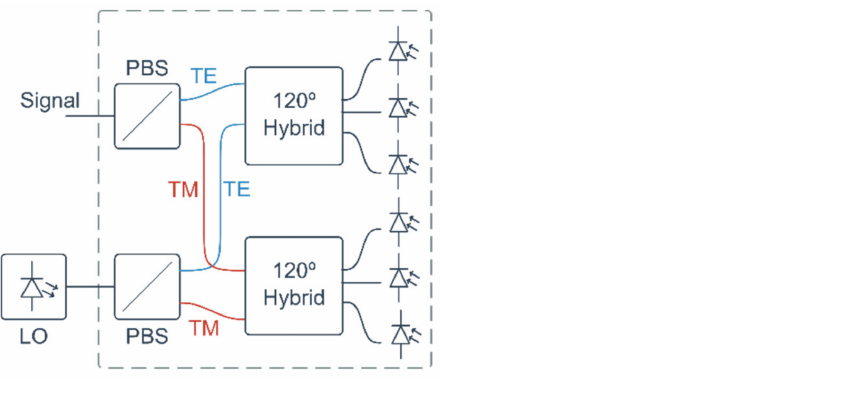
Figure 6. Dual polarization coherent receiver based on a 120 ◦